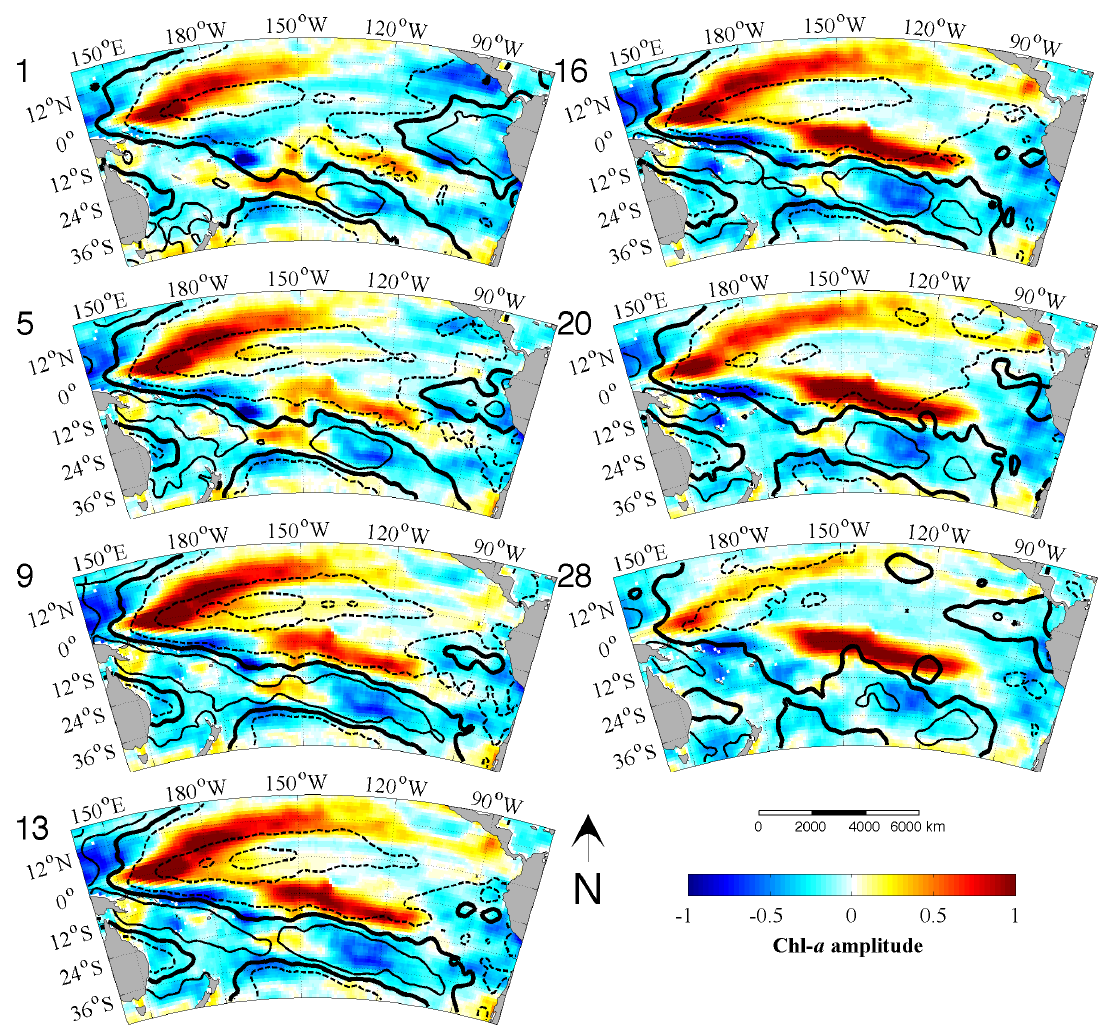
Figure 6. Chl -a A amplitudes from extended empirical orthogonal function (EEOF)-1 (L = 28) spatial lag-sequence overlaid with projected sea surface temperature anomaly (SSTA) contours in steps of 3. Units are non-dimensional [18]. Positive SSTA values are solid and negative values are dashed, while the zero line is bold. Months displayed are 1, 5, 9, 13, 16, 20 and 28, respectively. Panels are plotted on a Lambert